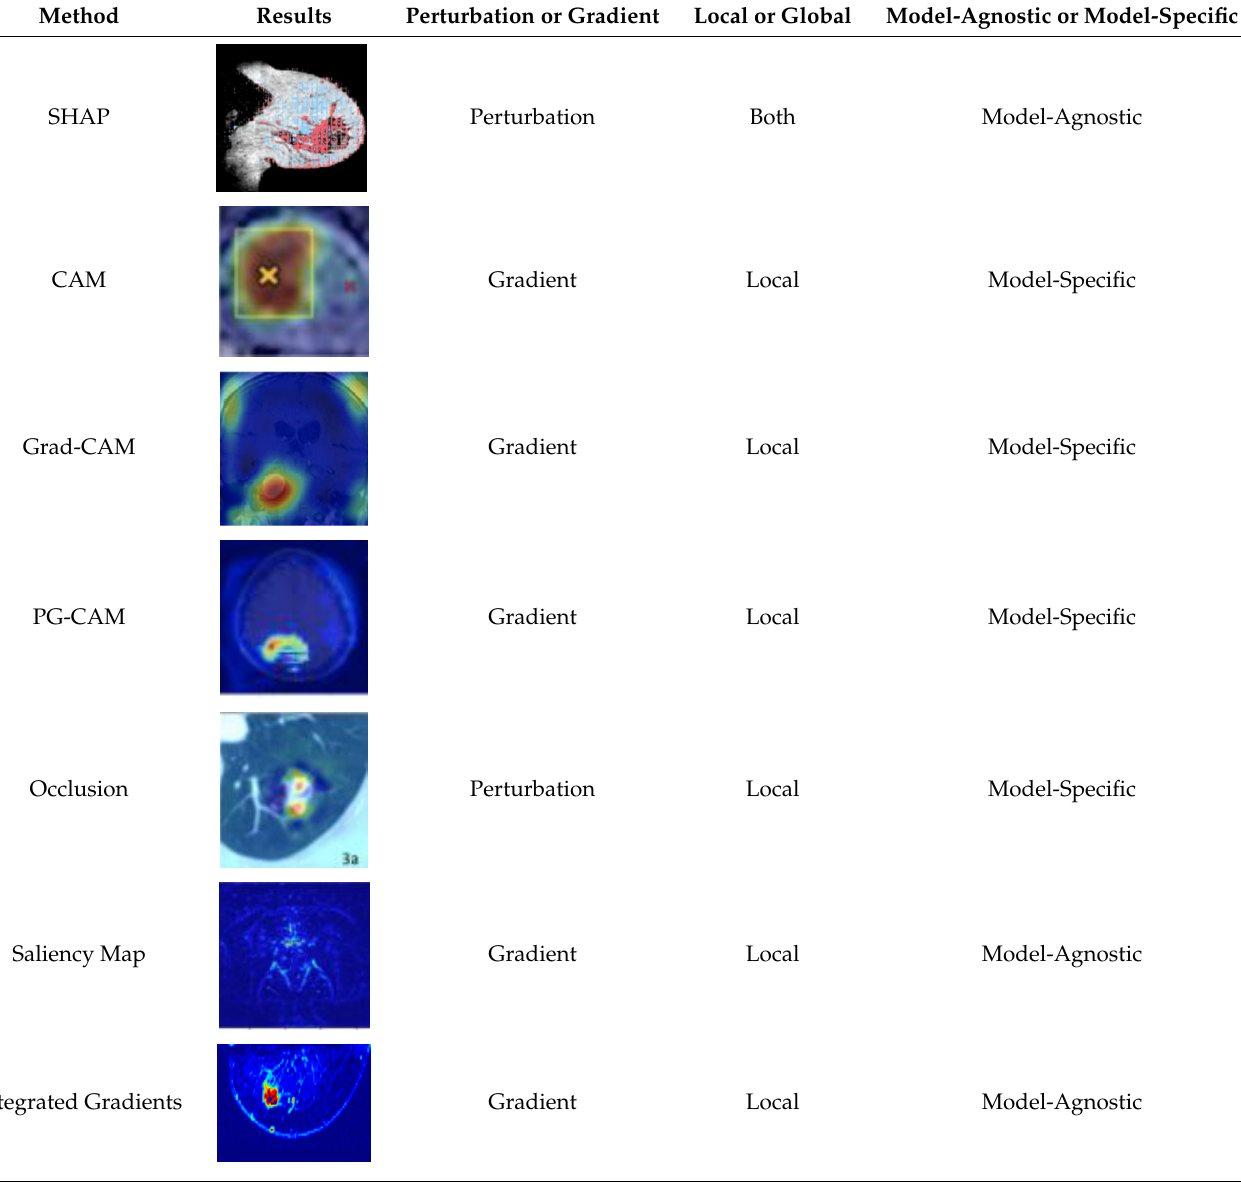
Table 1. Post-Hoc explanation techniques for cancer